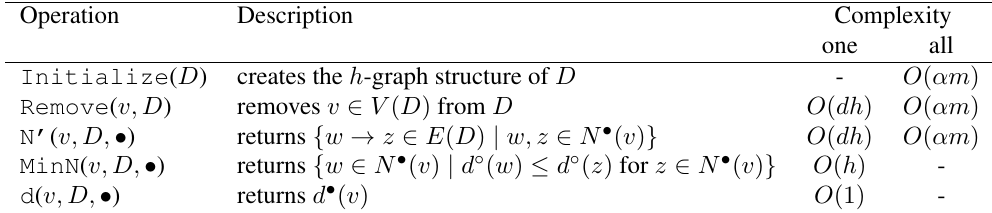
Tab. 2: Some operations supported by the h -digraph data structure. The complexity column “one” indicates the time required by one invocation of the operation, while the complexity column “all” indicates the time required when the operation is applied O (1) times to all the vertices in the digraph. Here h = h ( v ) , d = d ( v ) , α = α D and m = m D